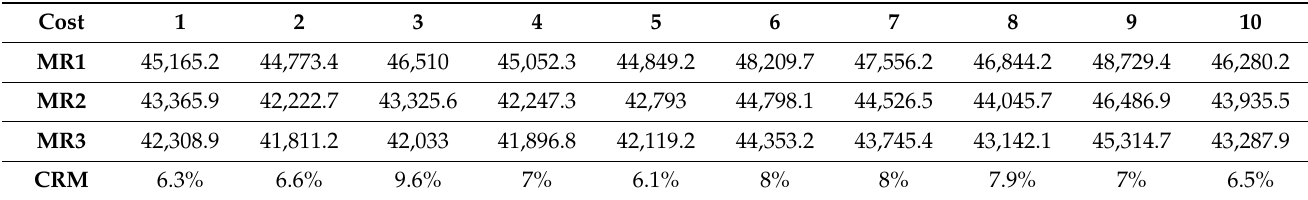
Table 9. Computational results of the third instances set in Case 3.